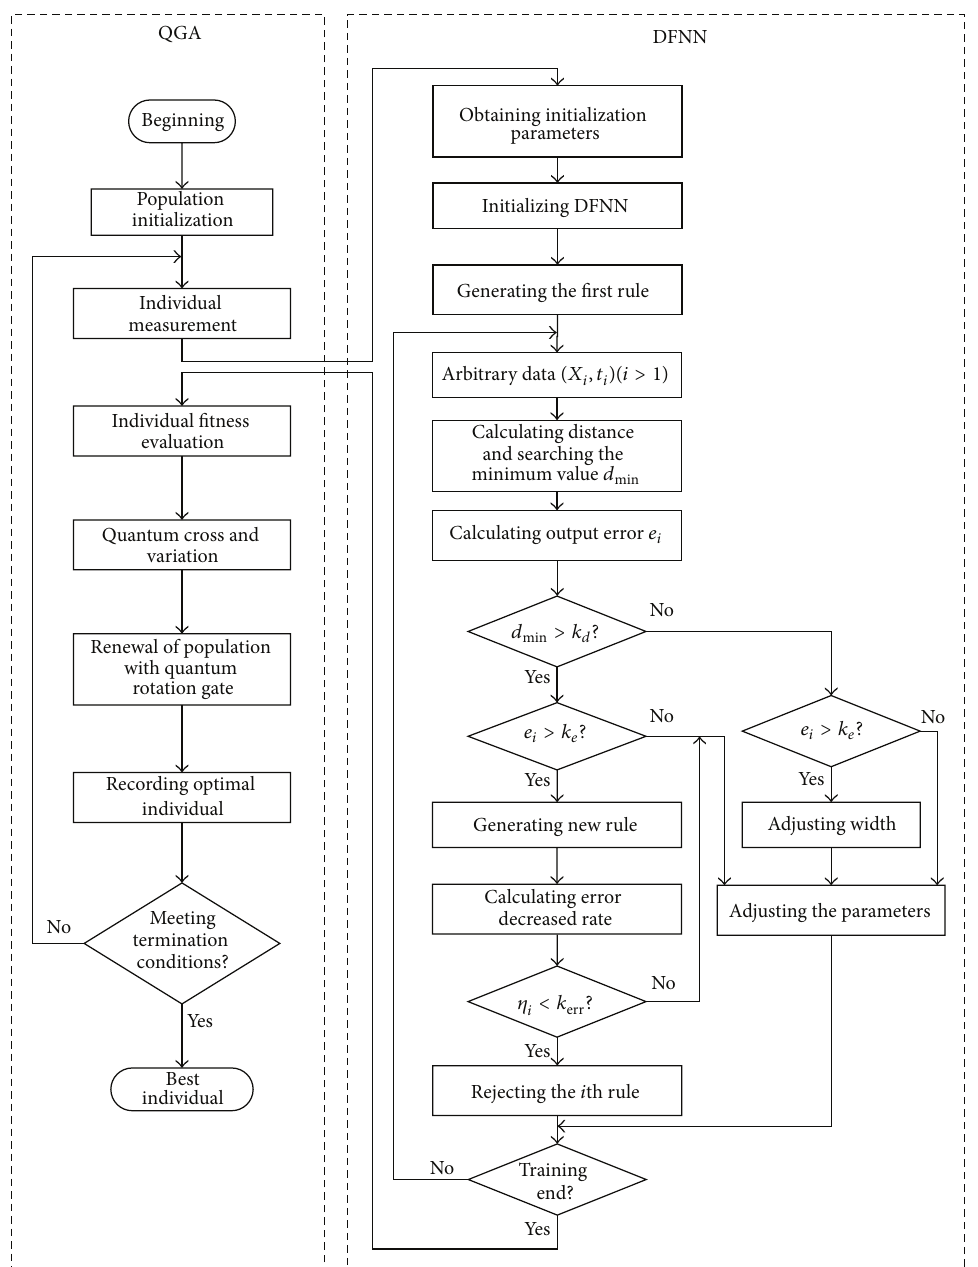
Figure 5: Algorithm flowchart of